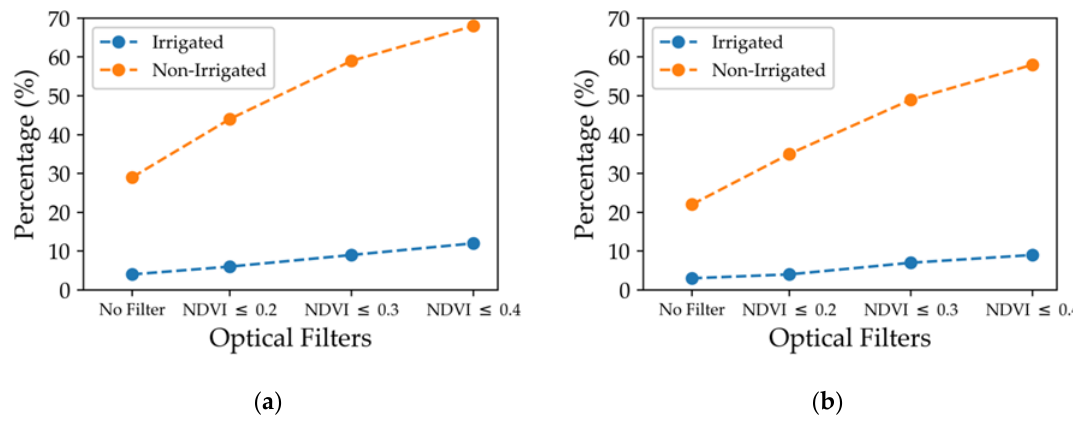
Figure 13. Percentage of plots with no detected irrigation points a function of the value of 𝑁𝐷𝑉𝐼 𝑡𝑖 used for the optical filter in Catalonia, Spain for irrigated (blue) and non-irrigated (orange) plots using ( a ) morning acquisition mode and ( b ) evening acquisition mode.